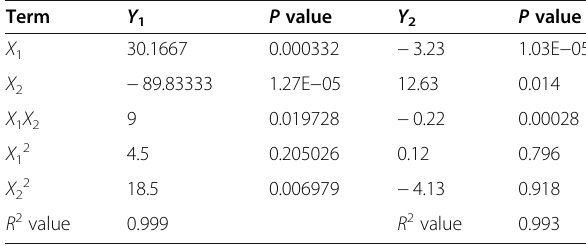
Table 3 Coefficient and P value for full model for variables in